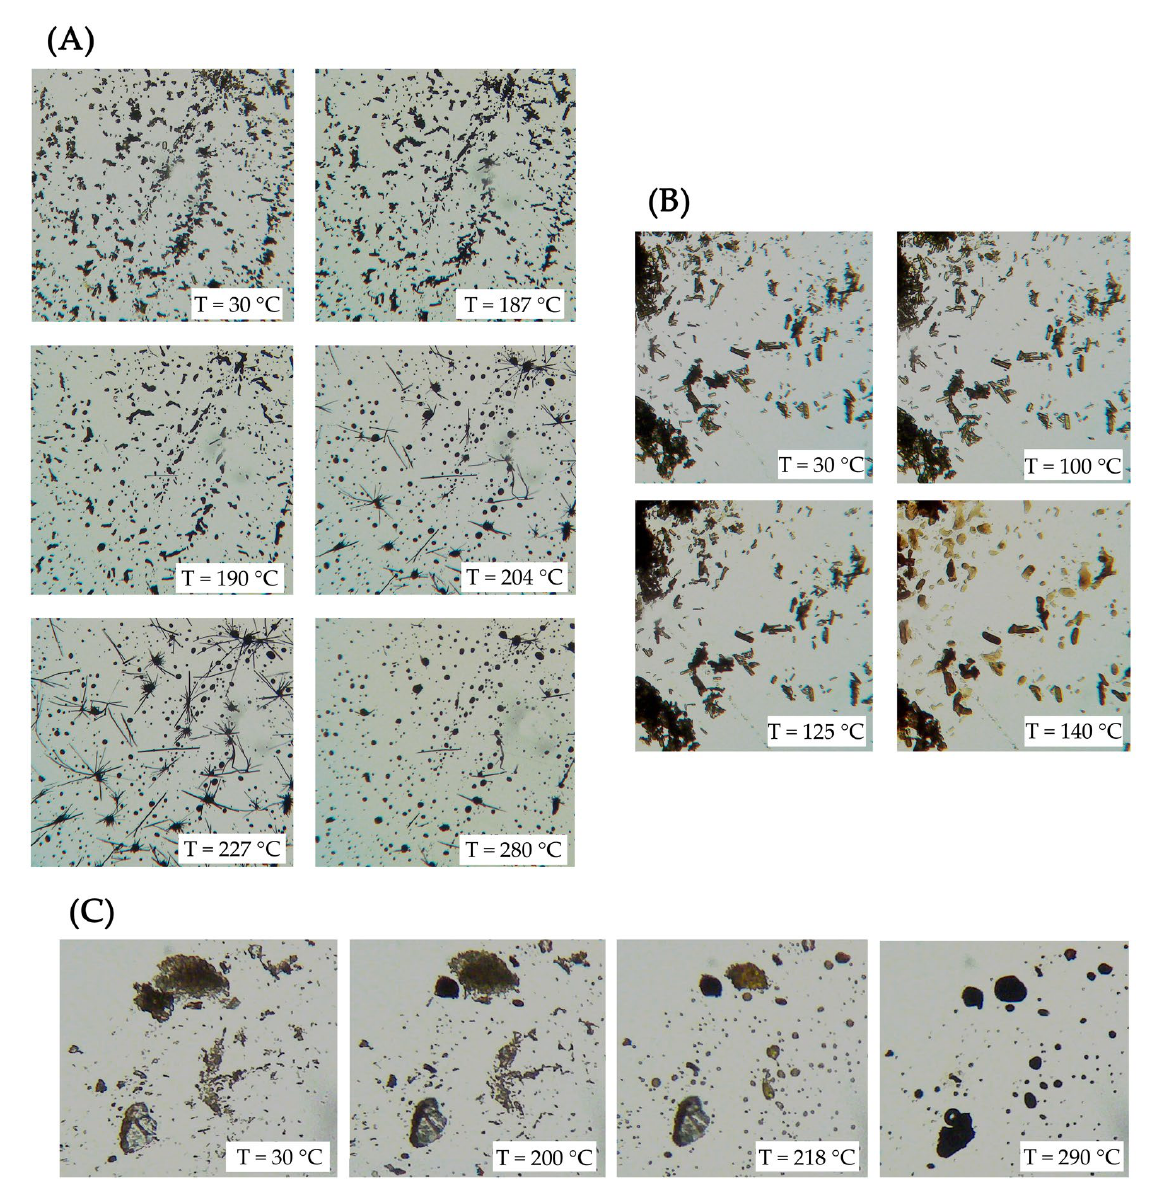
Figure 3. HSM photomicrographs of berberine chloride—BBR-HCl ( A ), berberine laurate—BBR-L ( B ), and berberine dodecyl sulfate BBR-S ( C ) were recorded at the various temperatures reported on the images. Photomicrographs show the morphological changes of each sample during the heating program.